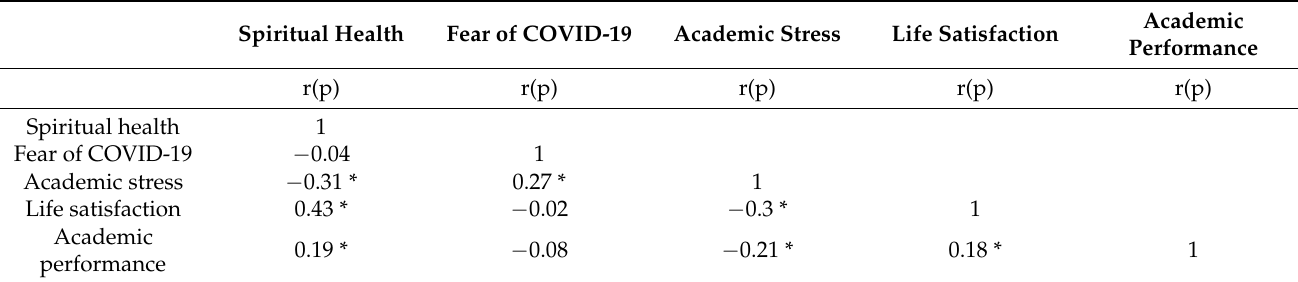
Table 3. Correlations of main variables ( N = 219).